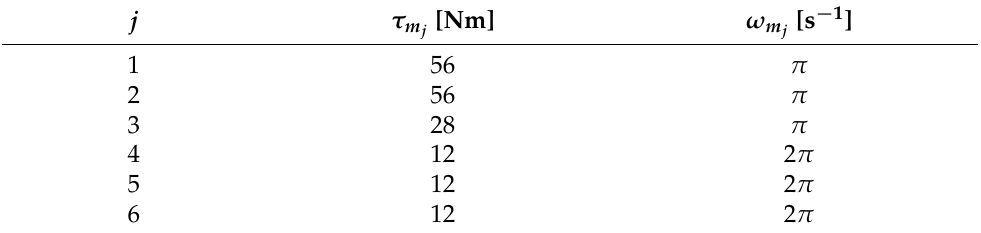
Table 1. The joint parameters for the UR3 robot; τ m the maximal permissible angular velocity of the j -th